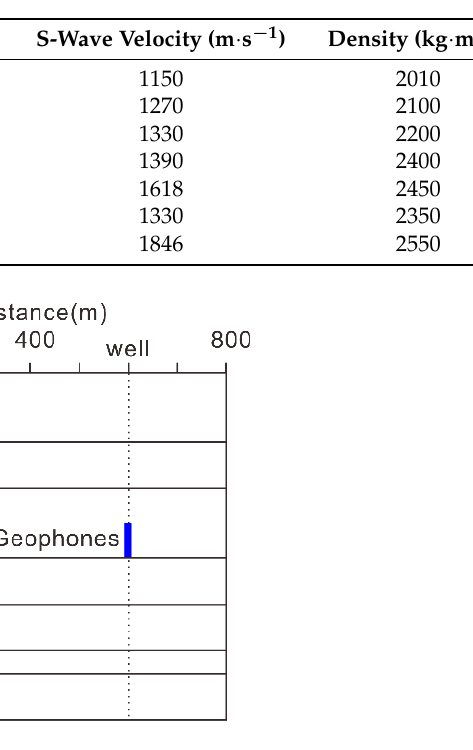
Figure 10. Sketch map of model 2. The red triangle is the resource and the blue line is the sequence of the geophones.